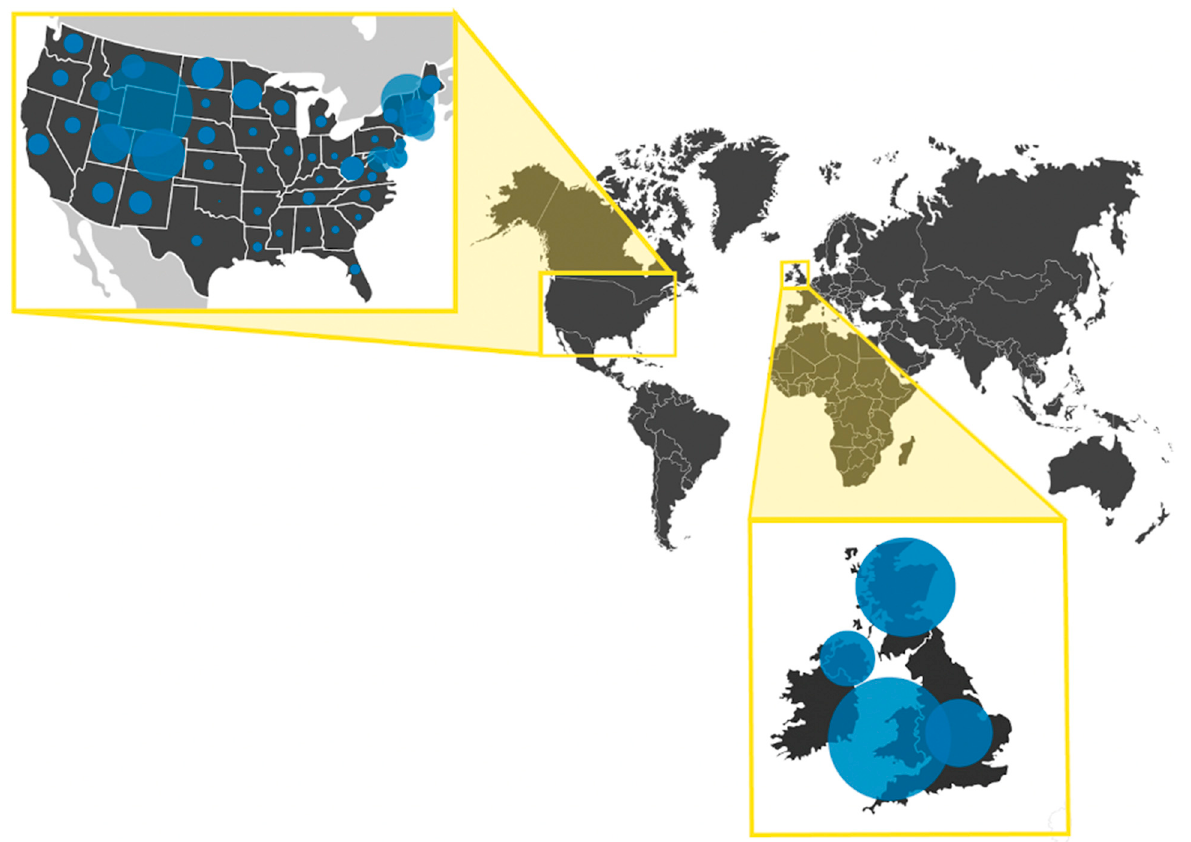
Figure 5. Relative sequence availability in the US and UK varies by region. The proportion of sequences from each state (USA) or region (UK) was calculated by dividing the sequence count from each region by the number of total sequences in the country (from GISAID as of 5 September 2022). Similar calculations were used to calculate the proportion of the population. The ratio of these two metrics is represented by the blue circles on the map.